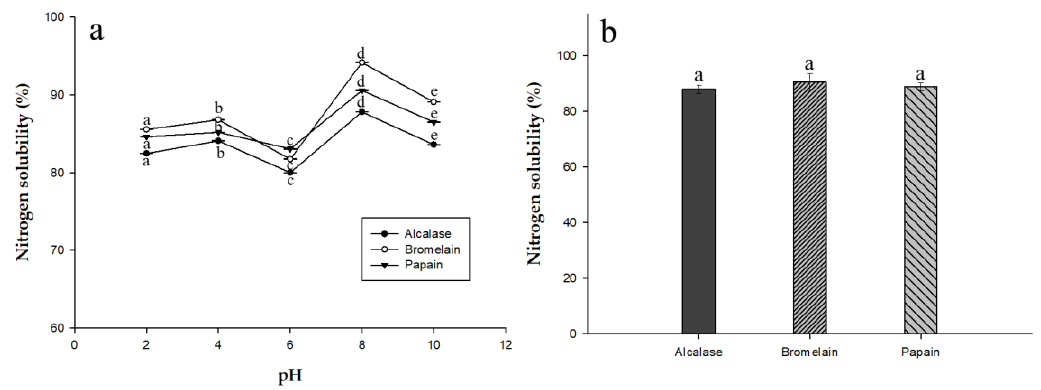
Figure 3. Nitrogen solubility (%) of the three EPHs in ( a ) water at di ff erent pH levels (2, 4, 6, 8, and 10) and ( b ) herbal eel extracts. Means in the same form with various characters have significant di ff erences ( p < 0.05). Data are expressed as mean ± SD from triplicate determinations.